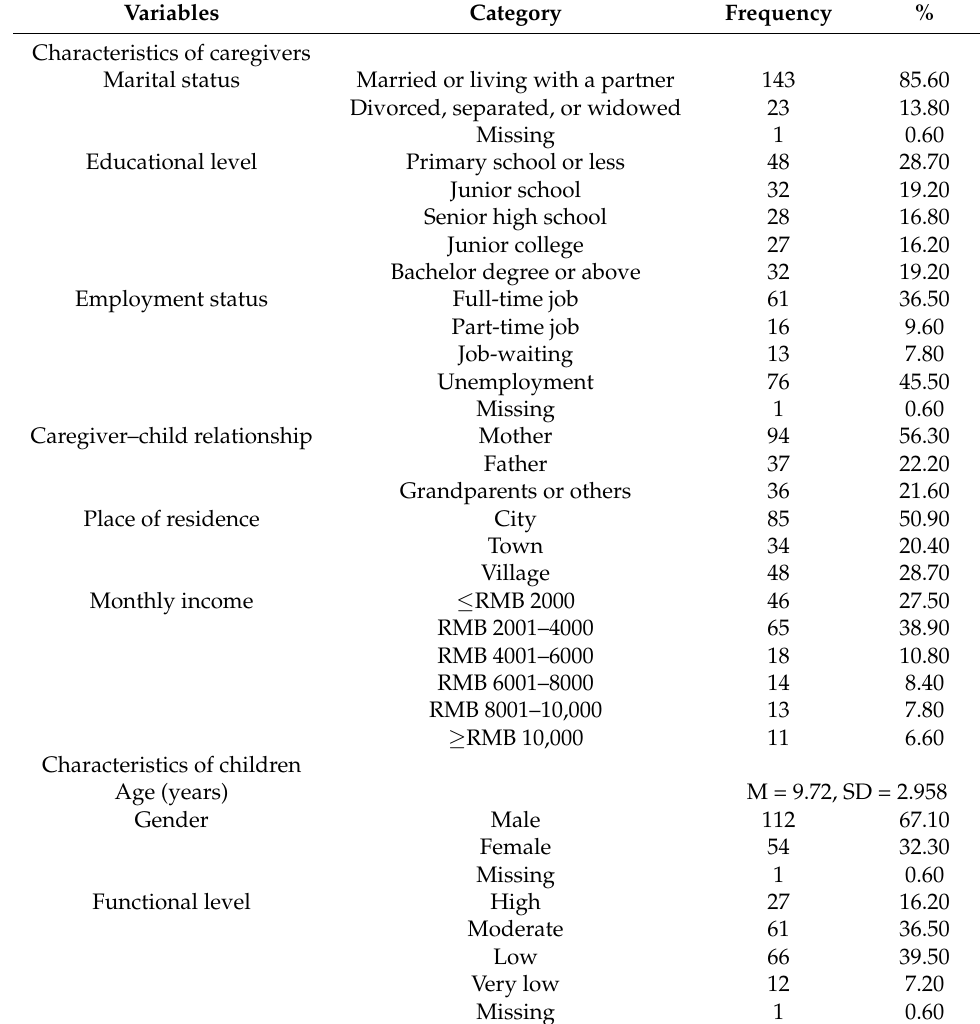
Table 1. Sample characteristics of the children and